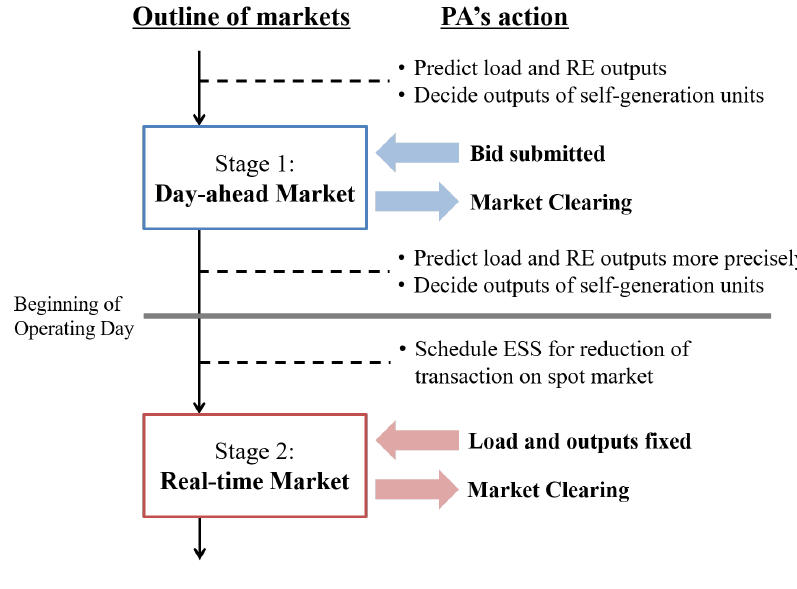
Figure 1. Scheme and flow of multi-period